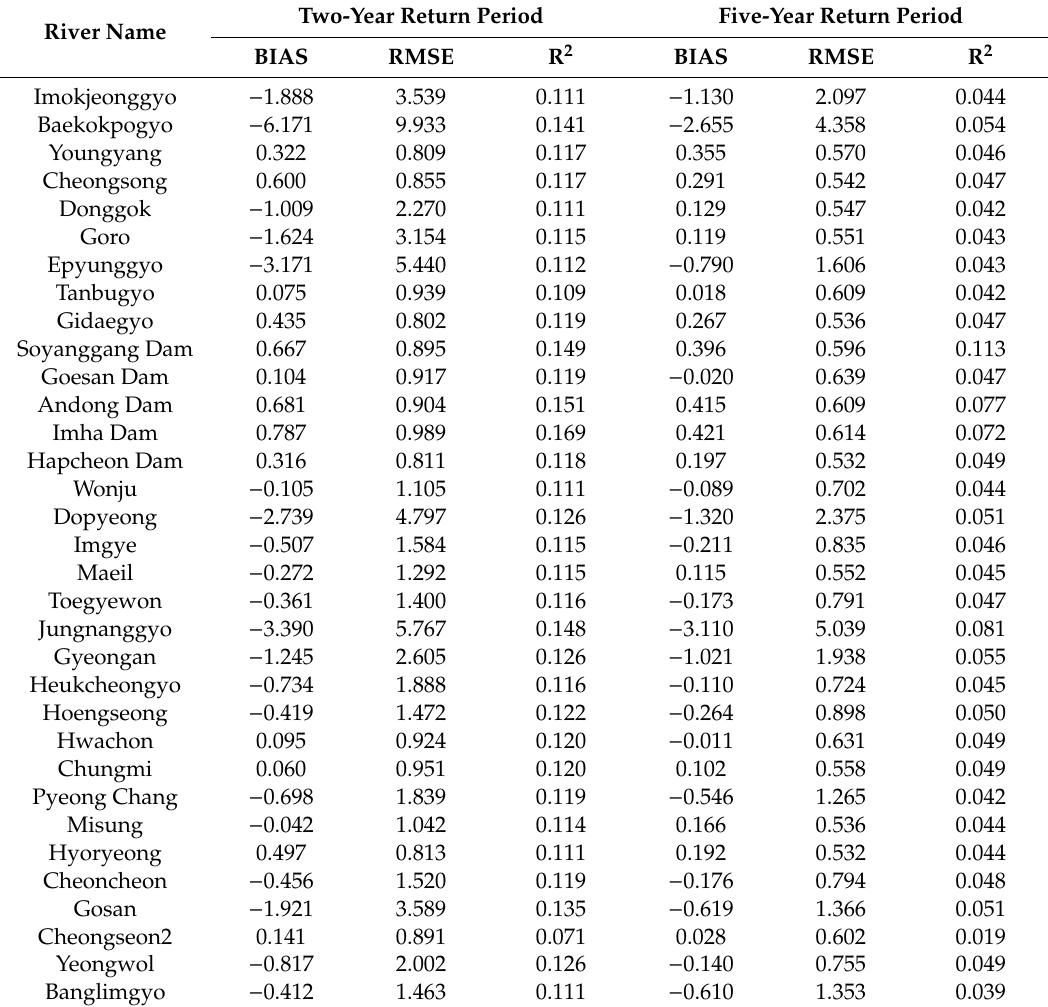
Table 4. Validation results using the drainage-area ratio method for the two-year and five-year low-flow